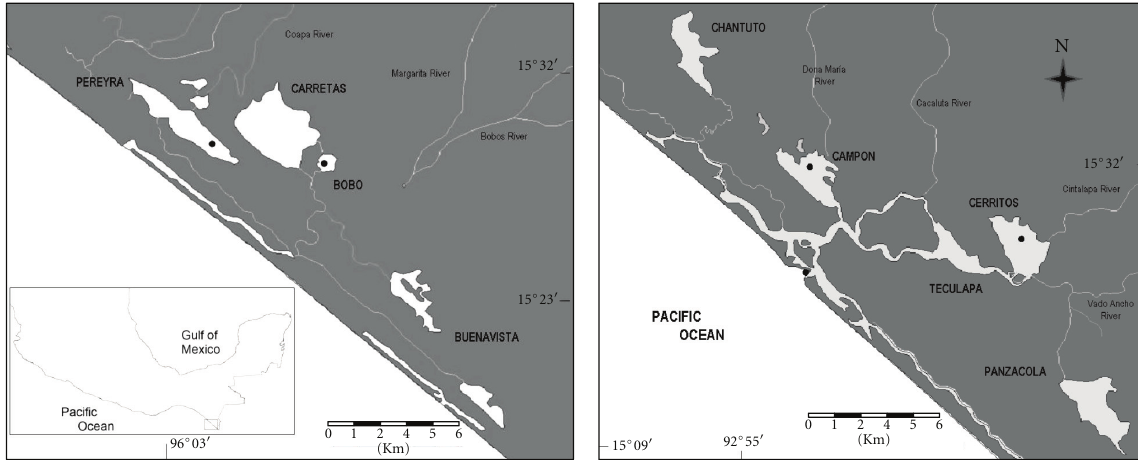
(b) Coastal lagoon system of Chantuto-Panzacola, Chiapas F 1: Study area and sampling sites